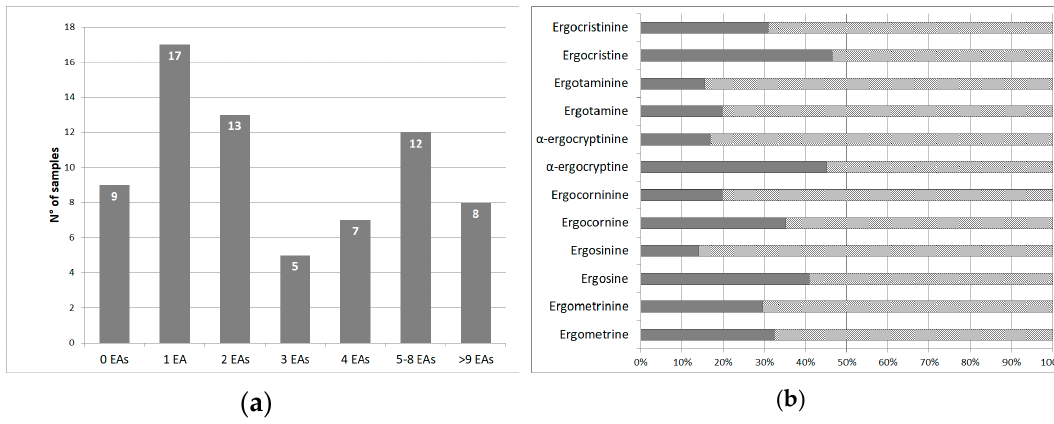
Figure 1. ( a ) Histograms representing the distribution of the number of EAs quantified per sample. ( b ) Percentage of samples resulted above or below the limit of quantification (LOQ) value for each EA, the percentage of positive samples being the solid grey portion of the histogram.